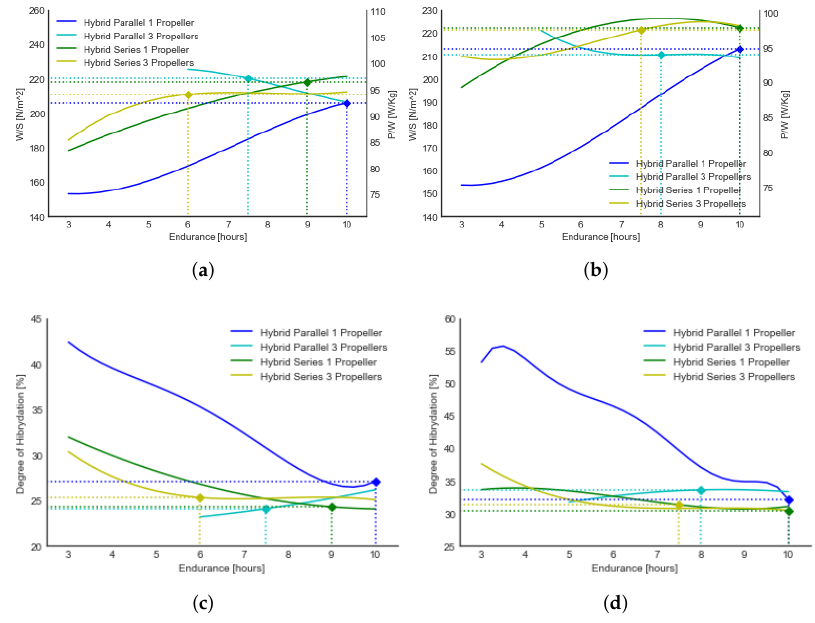
Figure 9. Comparison of design point. ( a ) Design points at 600 m cruise mission; ( b ) Design points at 2000 m cruise mission; ( c ) Degree of hybridization 600 m; ( d ) Degree of hybridization 2000